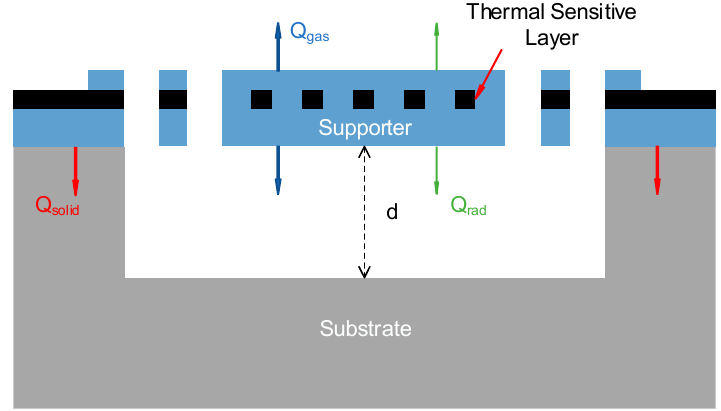
Figure 1. Heat transfer mechanism of the Pirani gauge.